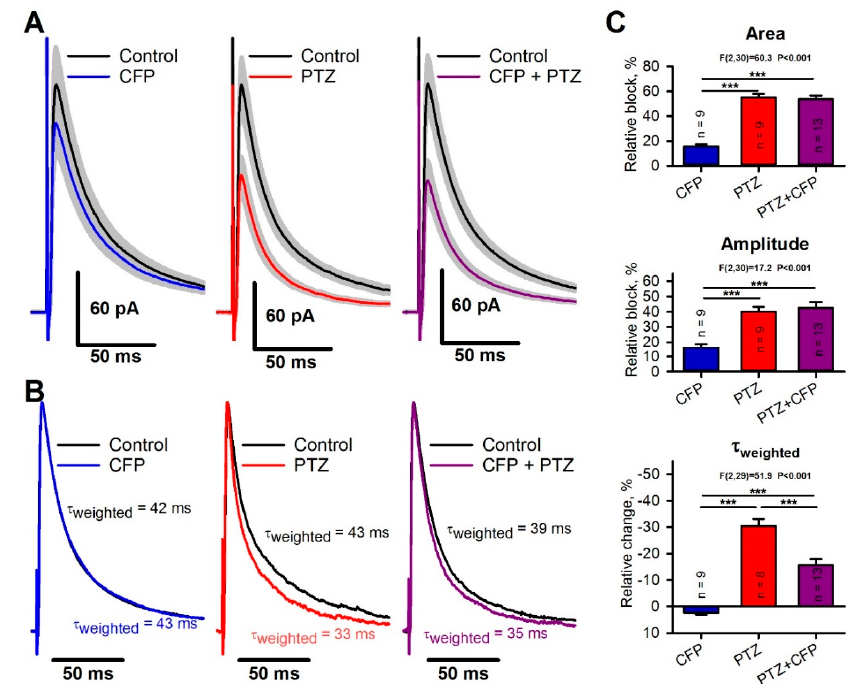
Figure 3. The effects of cefepime (CFP), pentylenetetrazole (PTZ), and their combination on γ -aminobutyric acid type a (GABAa) receptor-mediated evoked inhibitory postsynaptic currents (eIPSCs). ( A ) Averaged recordings of eIPSCs. The gray area represents the standard error of the mean. ( B ) Representative examples of normalized eIPSCs. Note that PTZ alone induces a more prominent decrease in the current decay constant than PTZ in combination with CFP. ( C ) The bar diagrams showing the e ff ects of drugs on the eIPSC area, peak amplitude, and weighted time constant. F-statistics and corresponding p -values are shown for a one-way analysis of variance (ANOVA). Asterisks